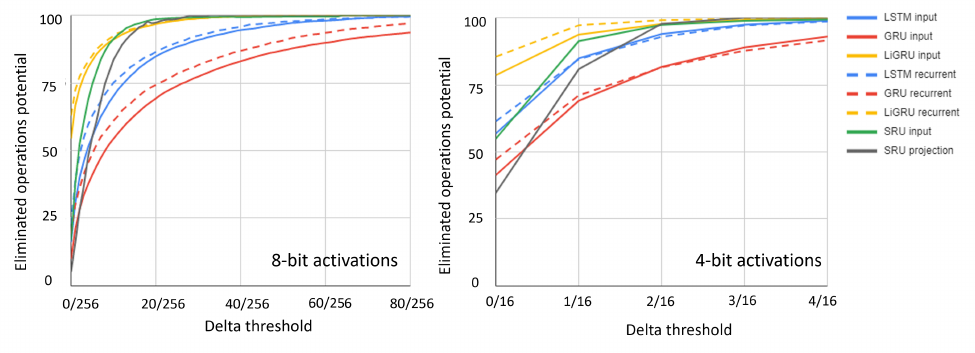
Figure 3. The eliminated operations potential plotted vs the delta threshold. In a delta vector, we computed the eliminated operations potential as the summed frequency of the delta threshold and all smaller delta thresholds. So, if a value is selected as a delta threshold, we can predict how many operations will be